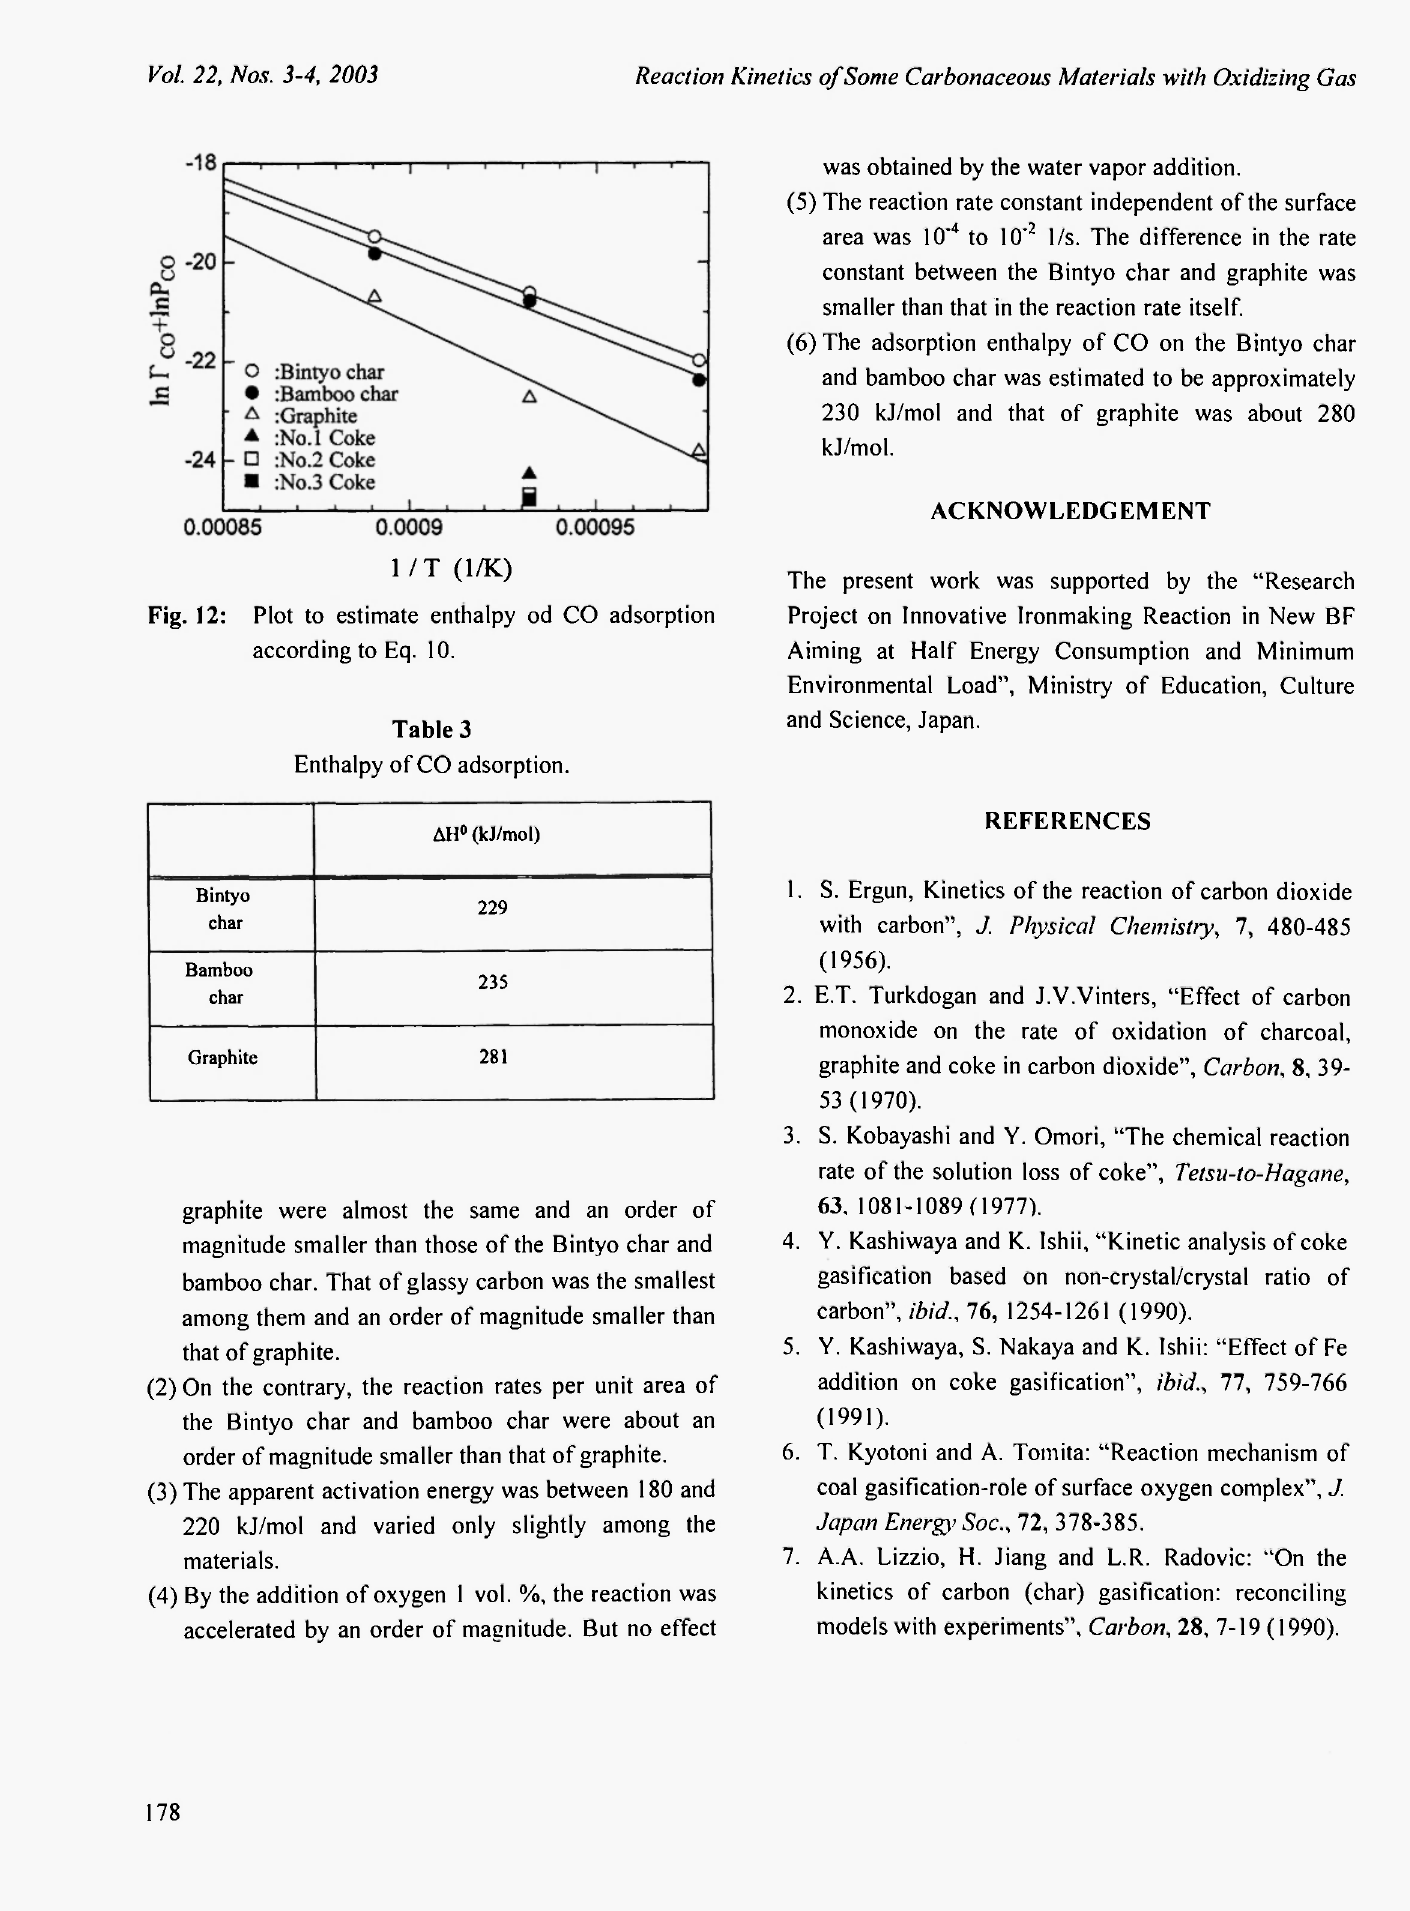
Fig. 12: Plot to estimate enthalpy od CO adsorption according to Eq. 10.